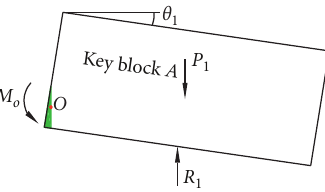
Figure 7: Mechanical model of key block A ( T � 0).